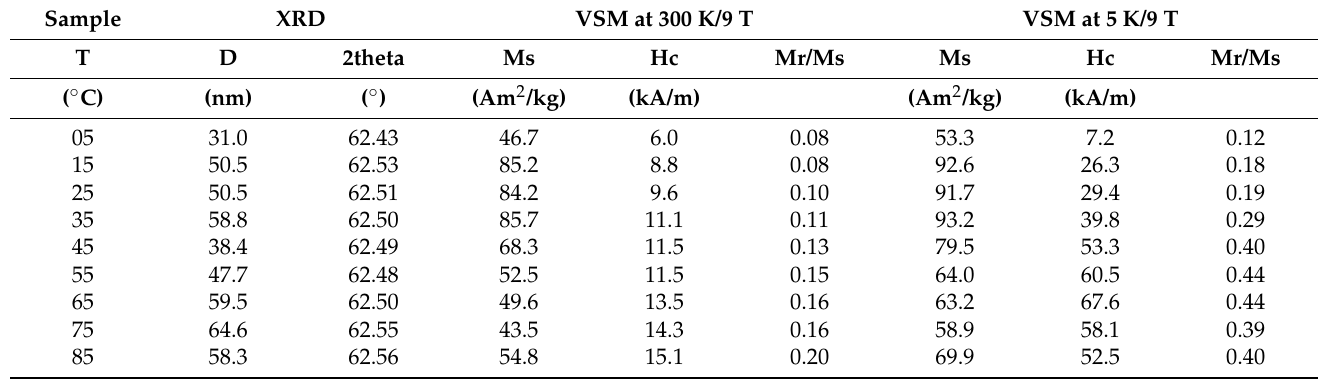
Table 1. XRD and VSM results for all particles.